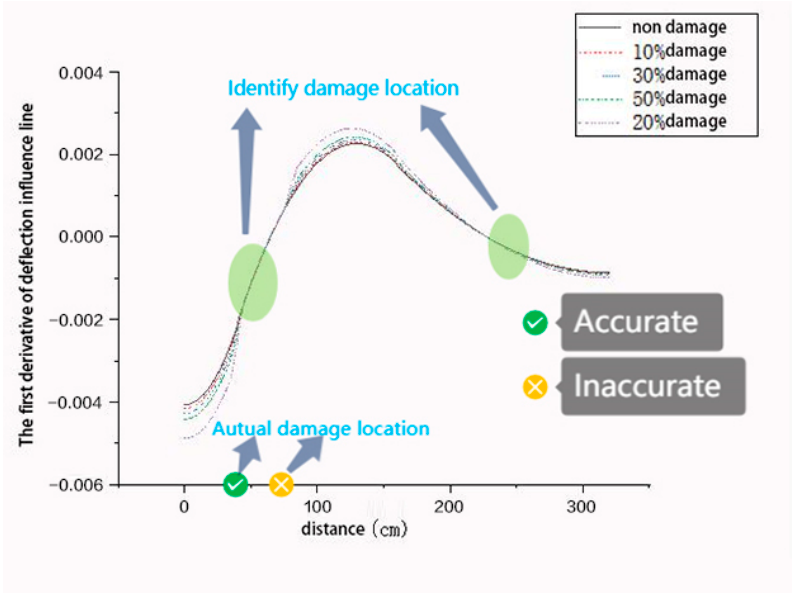
Figure 12. The 1st span1/4First derivative of deflection influences the point following work condition 2 (1-5).